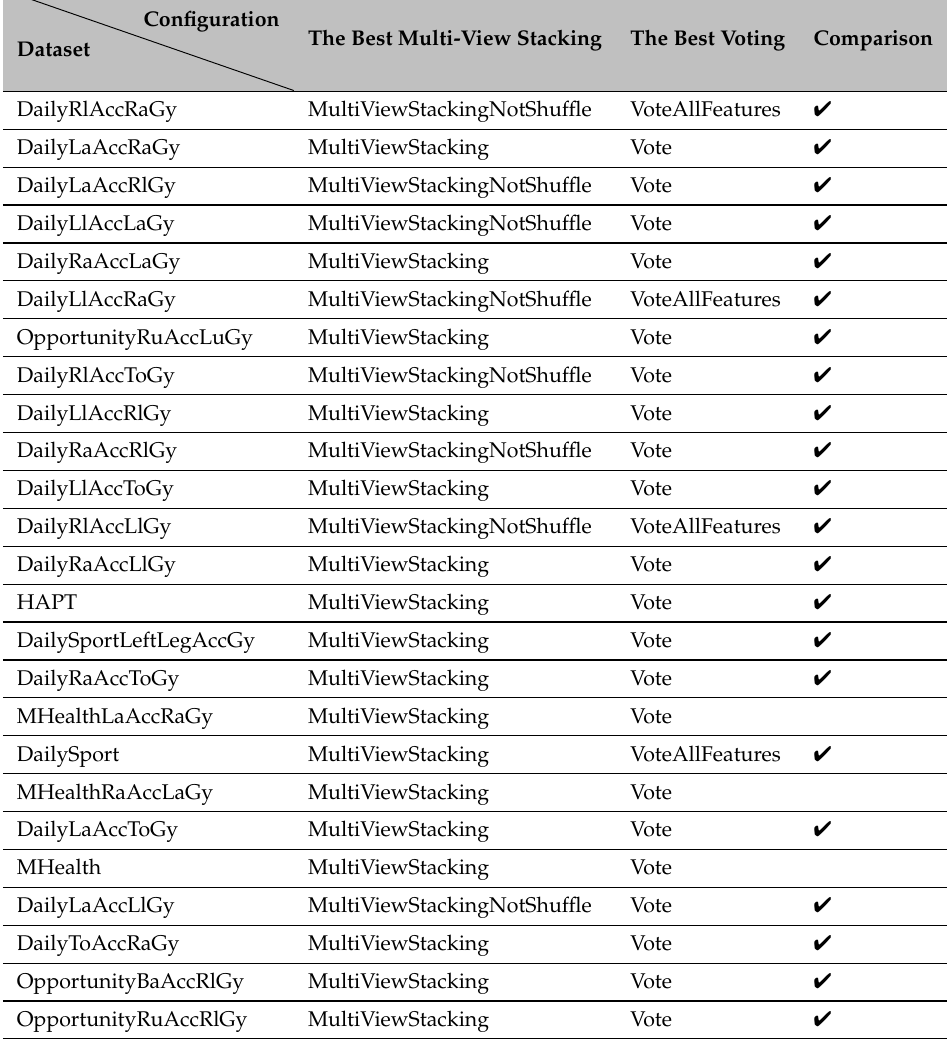
Table 4. Summary of the significant differences between the best of the configurations that include Multi-view stacking and the best of the configurations that include Voting. Configuration The Best Multi-View Stacking The Best Voting Dataset